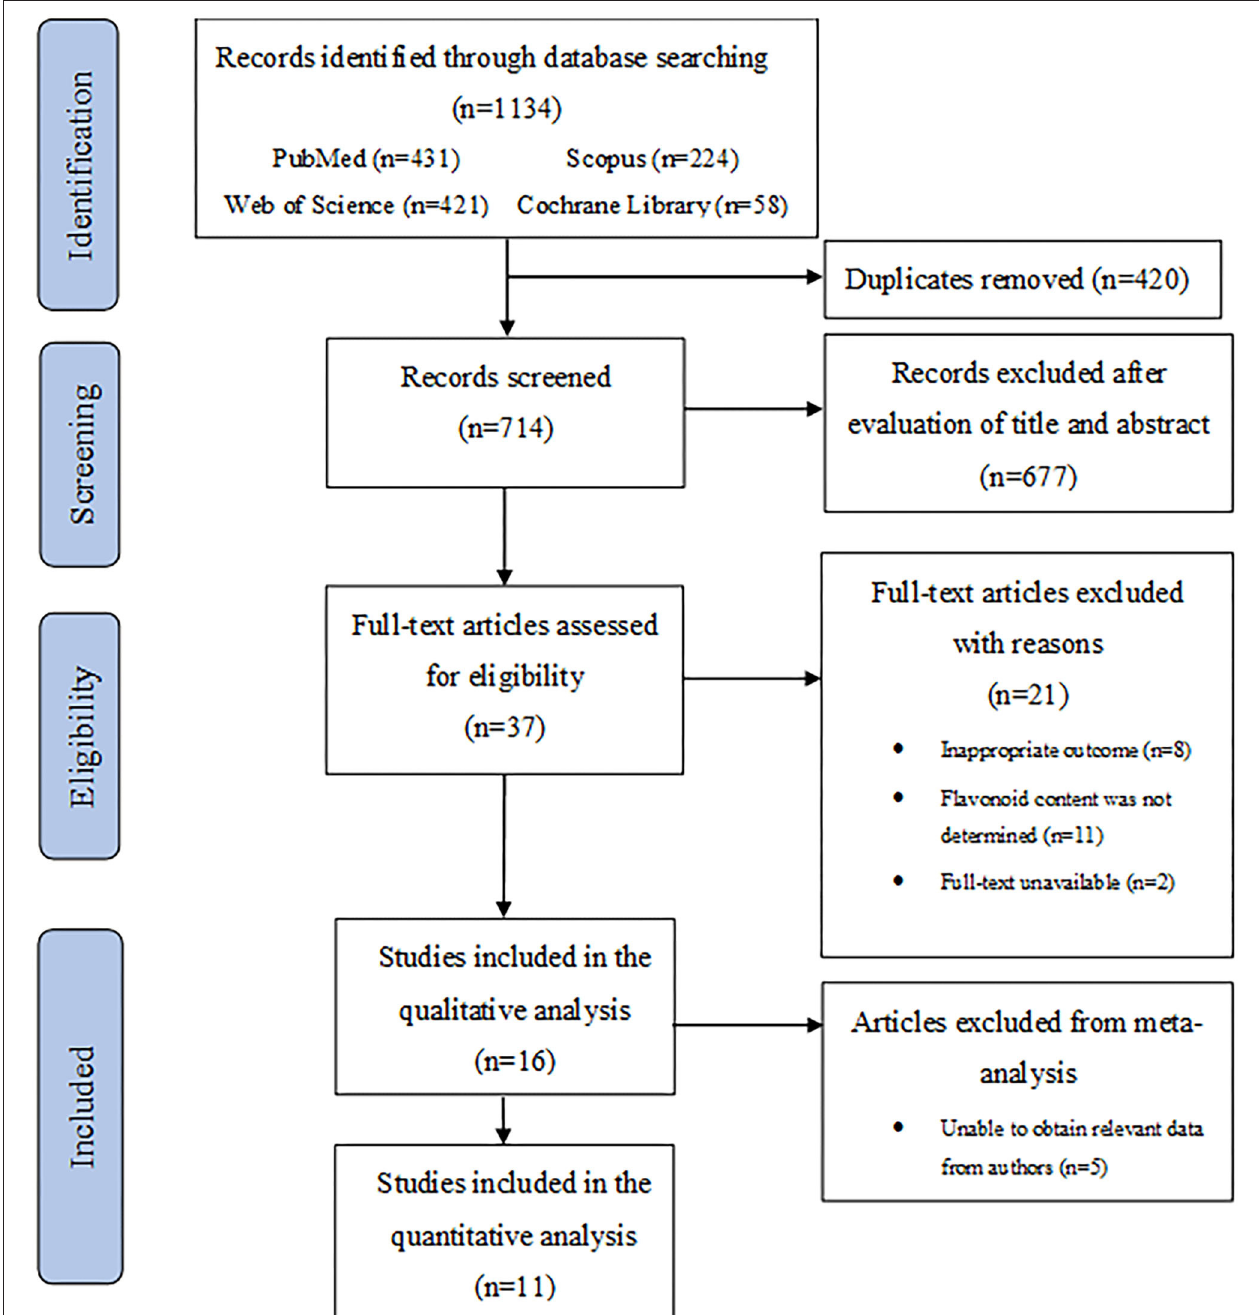
FIGURE 1 | PRISMA flowchart describing a systematic literature search and study selection.